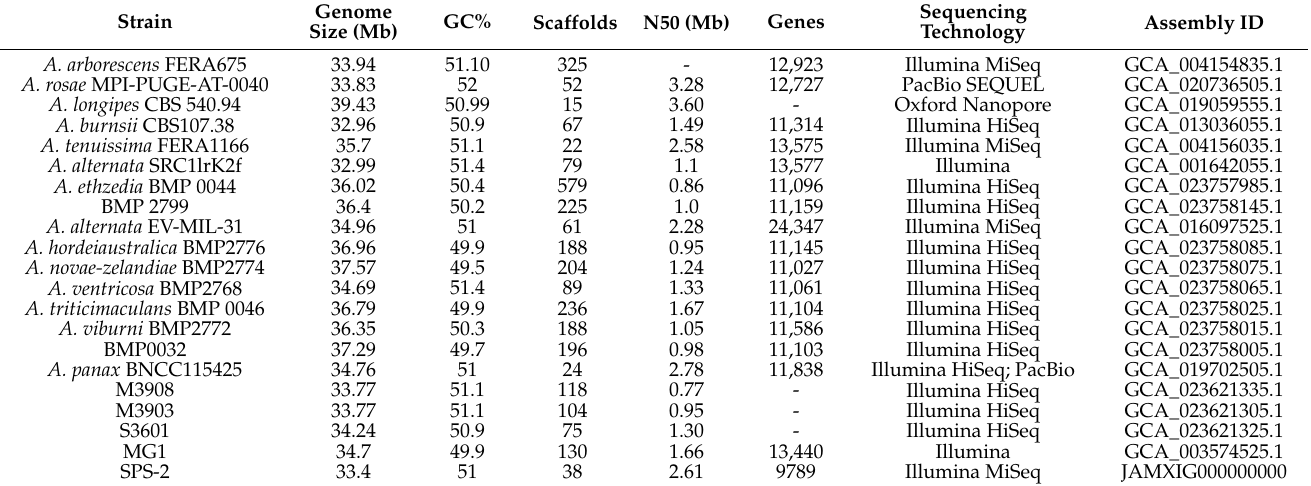
Table 2. Genomic features of all Alternaria strains available in the NCBI database.